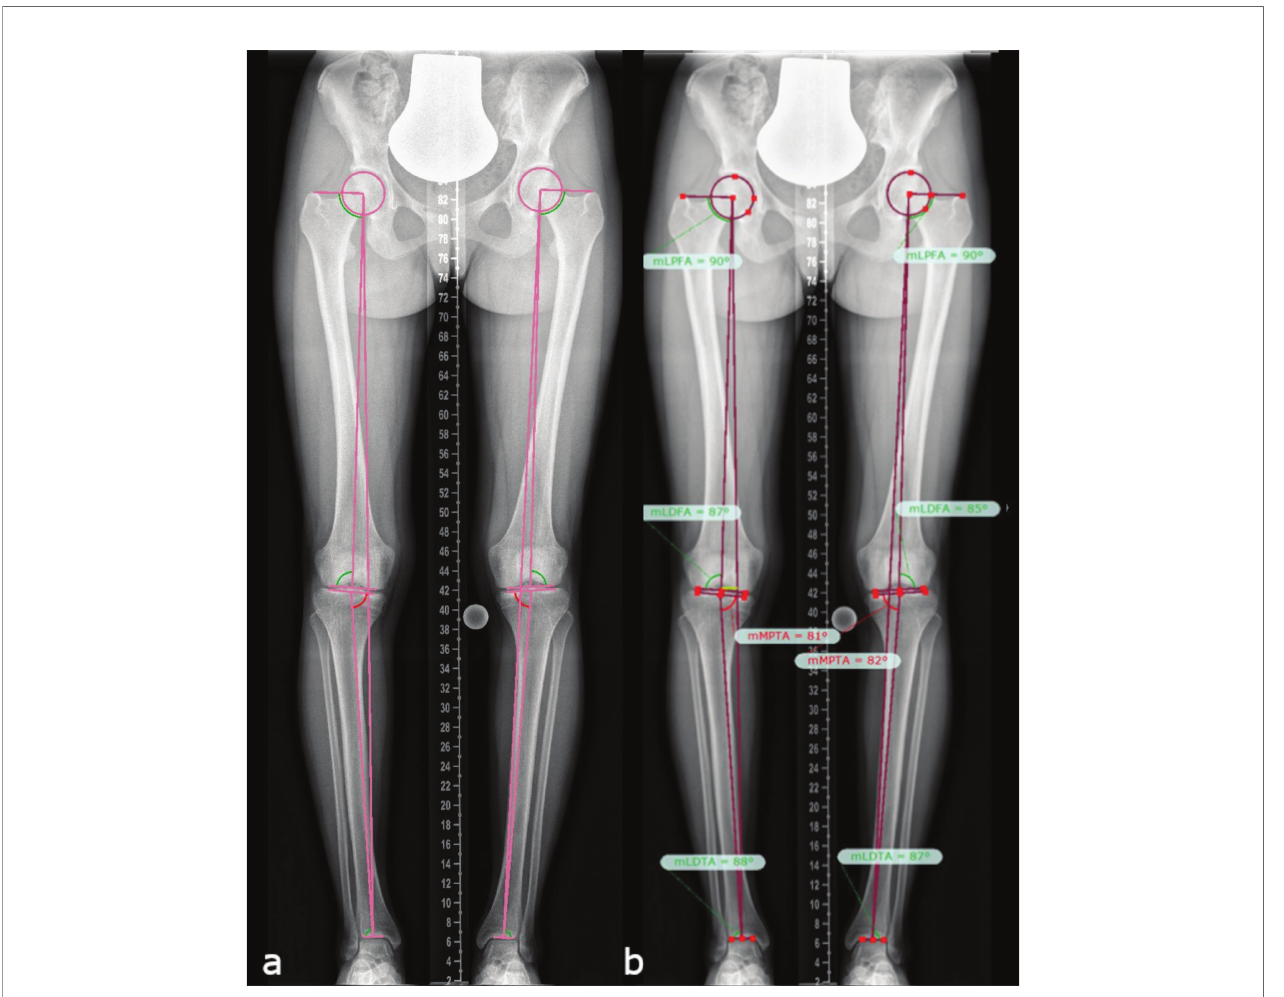
FIGURE 1 | Lower limb deformity measurements on full-length anteroposterior radiograph images (hip to ankle) of both lower limbs in standing position (A) , as assessed using the TraumaCAD software according to standard measurement protocols (B) (14, 15), in a patient with mild XLH (18 y/o, female, BMI of 21.6 kg/m 2 , GDI of 89.8, no surgeries, receiving conventional treatment since childhood, and mild bilateral varus deformity proximal